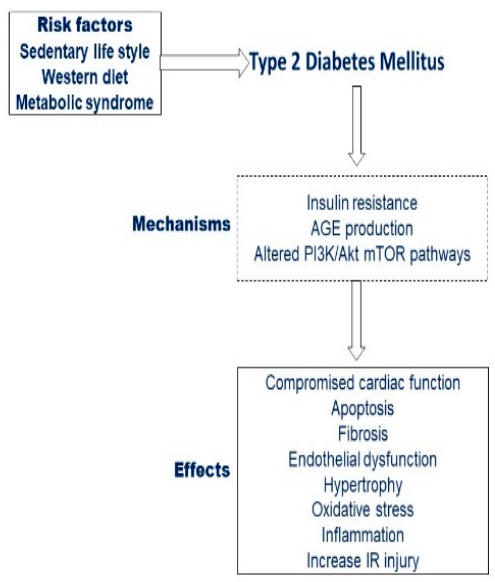
Figure 3. Risk factors leading to diabetes and effects on the cardiovascular system.